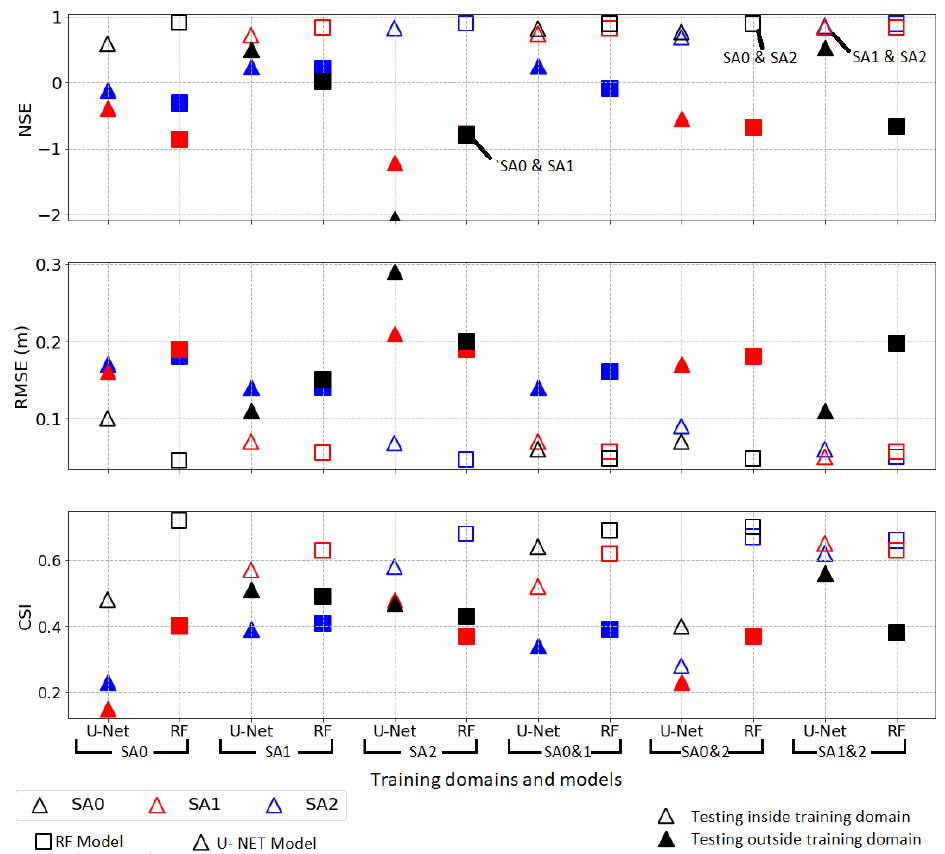
Figure 4. Computed performance indices (based on the testing dataset) for different combinations of training datasets for both the U-Net and RF models. The x axis shows the model used and the training domain, while the y axis shows the performance indices. The U-Net-SA1&2 model had the best performance within and outside the training